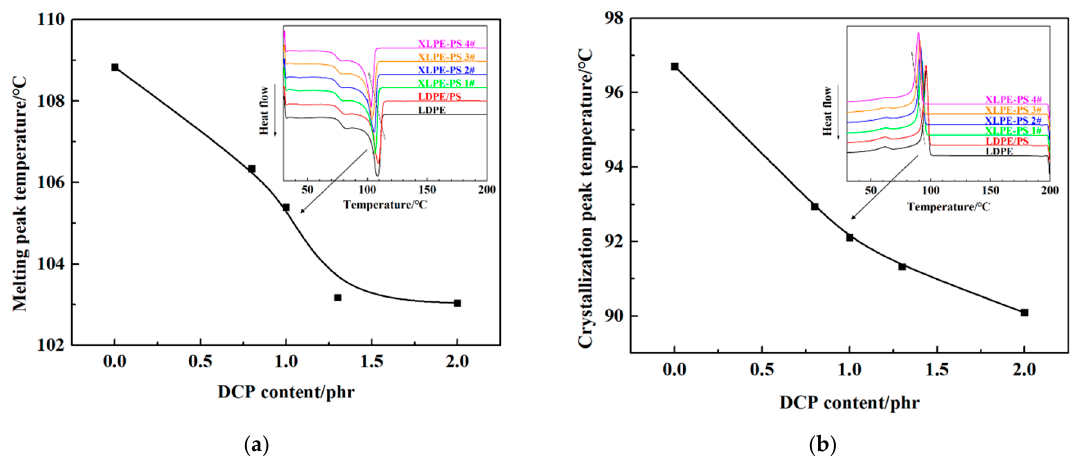
Figure 7. Effects of DCP content on melting and crystallization behaviors of samples: ( a ) melting process; ( b ) crystallization process.